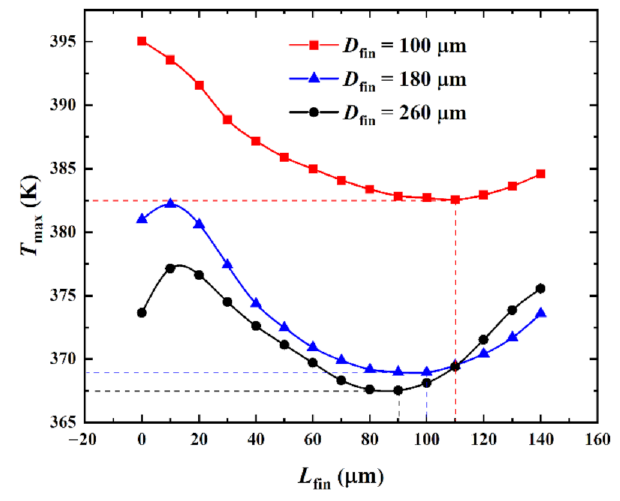
Figure 9. Effect of D fin on T max versus L fin